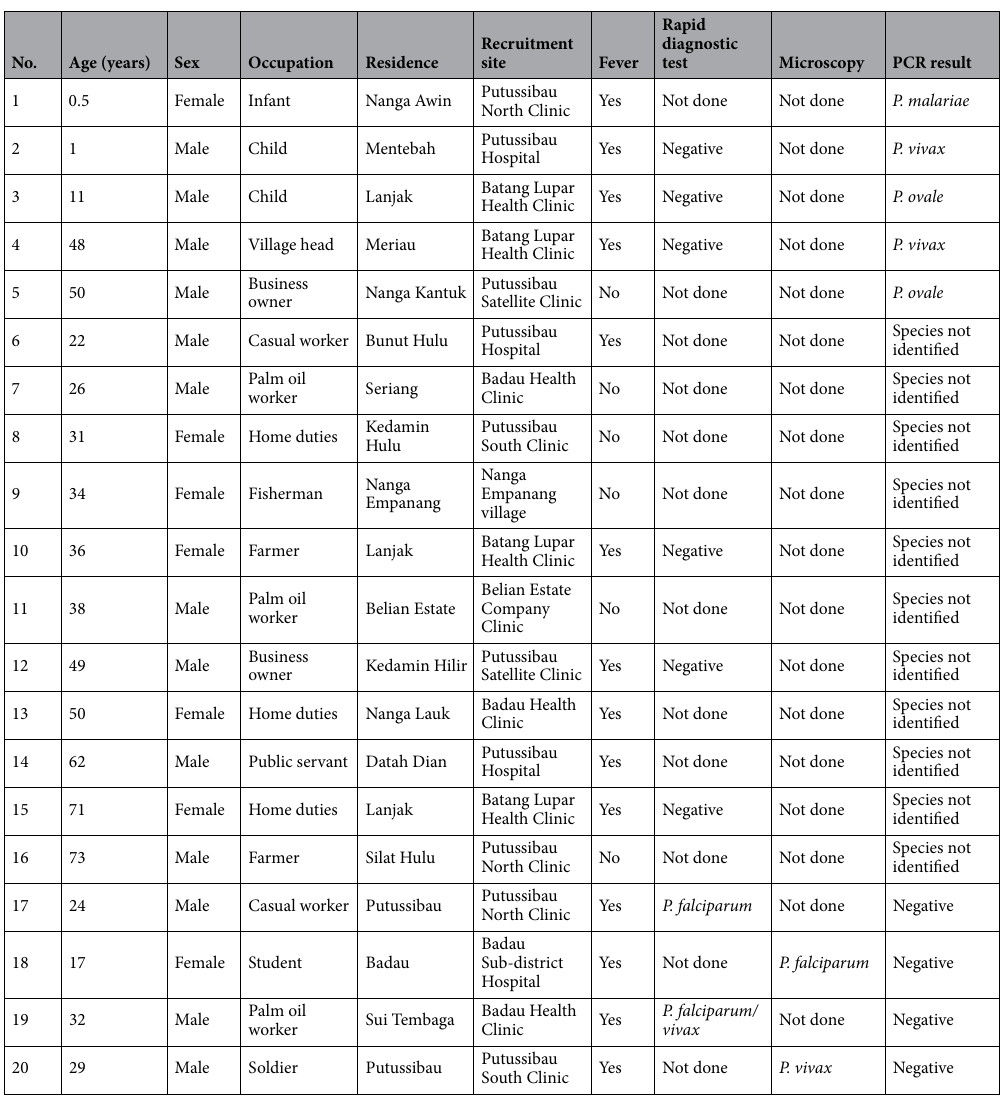
Table 2. Details of cases of malaria diagnosed by PCR with the species identified (cases 1–5), those who were PCR positive but without an identified Plasmodium species (cases 6–16), and those who were positive by rapid diagnostic test or microscopy but negative by PCR (cases